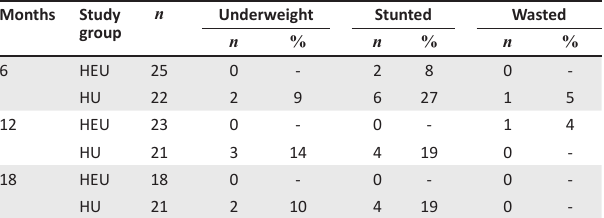
TABLE 4: Nutritional indicators of HIV-exposed uninfected and HIV-unexposed infants. Months Study